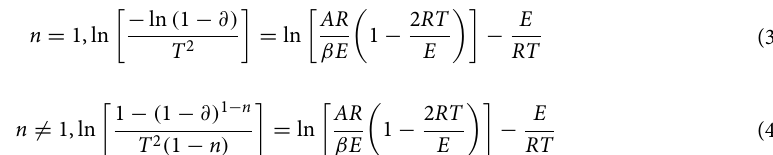
good parallelism between the stripes, most of the stripes show the characteristics of distribution in different directions, so the stacking height (Lc) and l the number of aromatic layers per stack (n) in this study are randomly selected for the measurement of orderly stripes in the 3 nm × 3 nm region. The distance between the effective nearly parallel stripes in the region is the stacking height (Lc), and the number of stripes is the number of aromatic layers per stack (n) 26 .